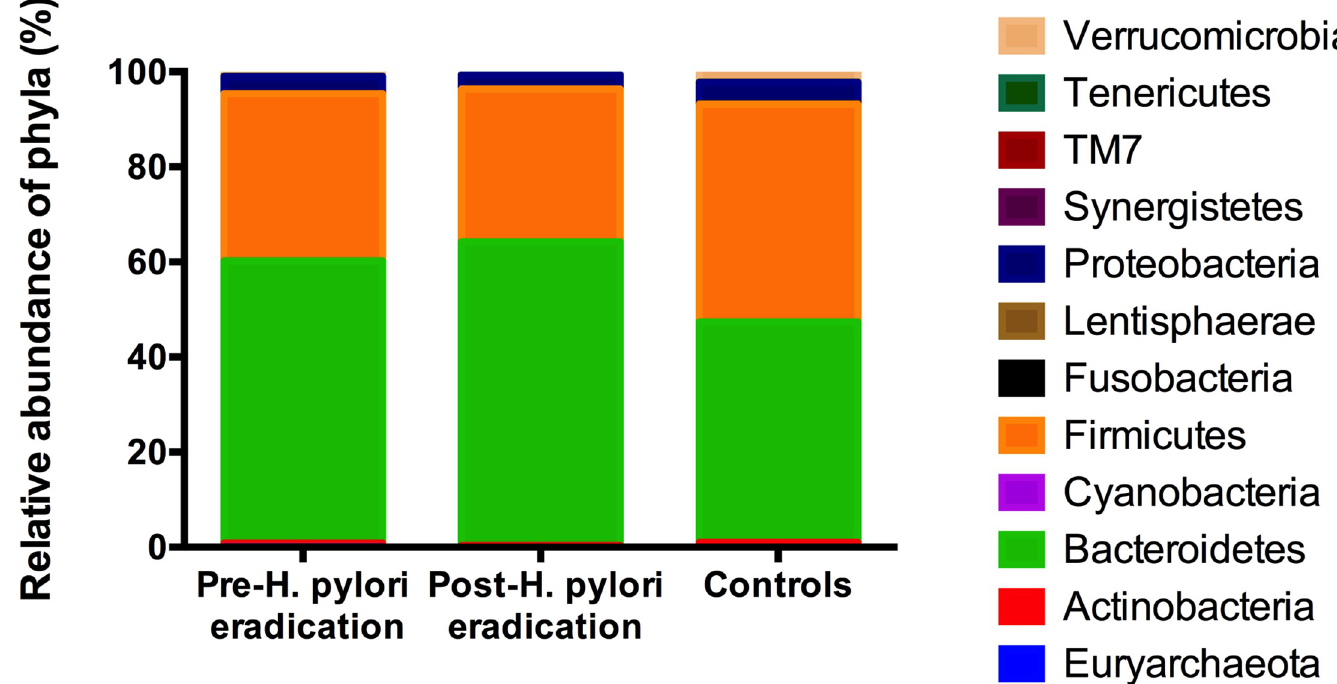
Fig 4. Mean relative abundance of bacterial phyla (%) in the controls and patients before and two months after H . pylori